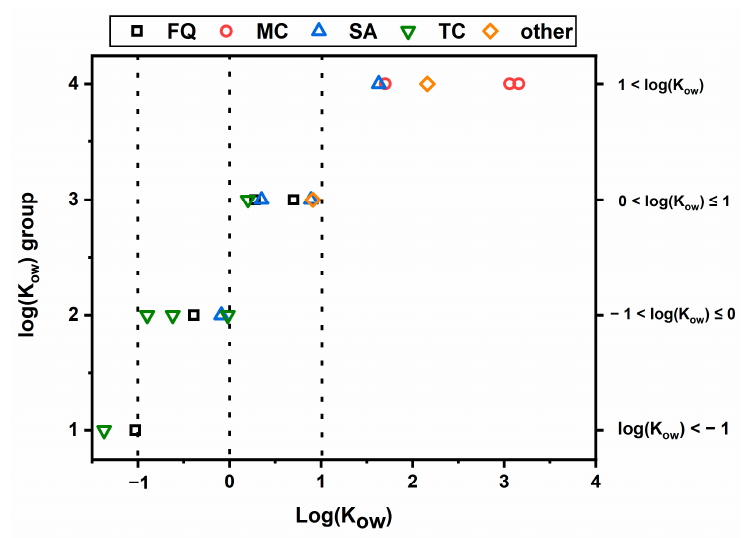
Figure 1. The ABs regrouped into four groups after their log(Kow) values ( y -axis). Four fluoroquinolones (FQ), three macrolides (MC), five sulfonamides (SA), four tetracyclines (TC), and others (clindamycin and trimethoprim). For erythromycin-H 2 O, the value of log(Kow) was not available.